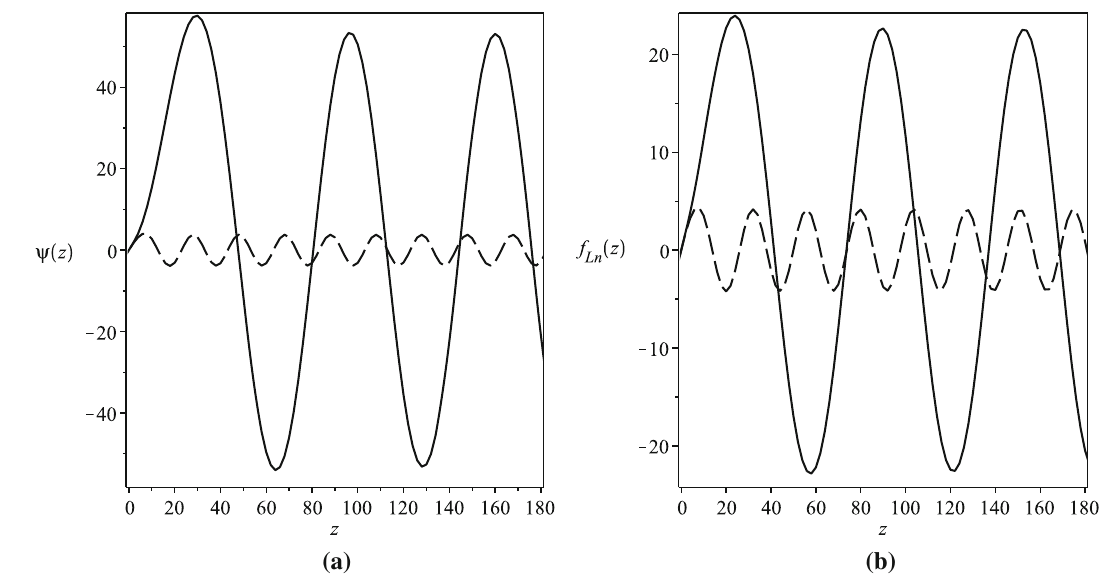
Fig. 11 The profile of a graviton wave function and b right-handed fermion wave function for m 2 n < V max (solid line), m 2 n > V max (dashed line), in all cases we have a = 5 and η = 1 for fermion case